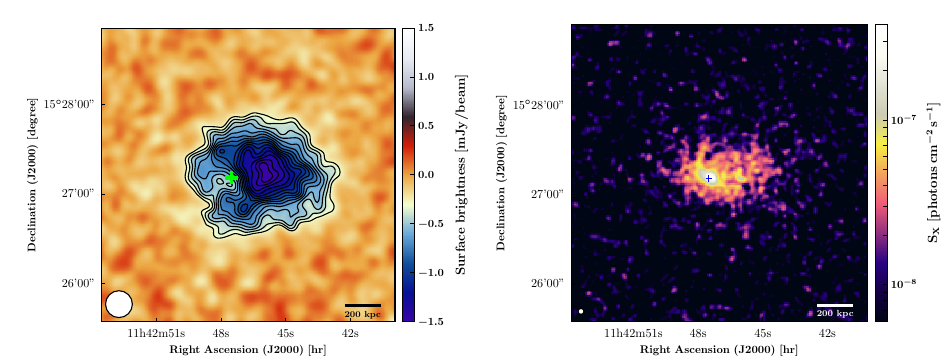
Figure 1. Left: NIKA2 surface brightness maps of MOOJ1142 + 1527 at 150 GHz smoothed with an additional 8 arcsec FWHM Gaussian filter. Significance contours starting at 3 σ with 1 σ steps are shown in black. The white disk in the bottom corner gives the width of the NIKA2 beam at 150 GHz. Right: Chandra exposure-corrected map of MOOJ1142 + 1527 in the 0.7-7.0 keV band smoothed with an additional 3 arcsec FWHM Gaussian filter. The green and blue crosses in both panels give the location of the radio source in the cluster. Figure extracted from